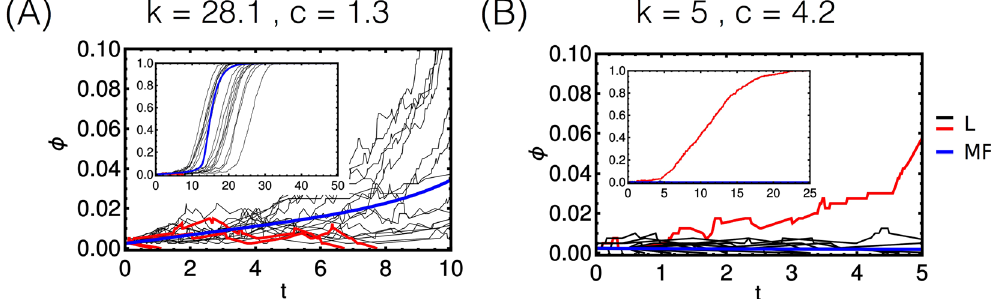
Figure 6. Bi-stability in the spatial model. ( A , B ) Aberrant cell fraction ( φ ) plotted against time for the mean field model (blue line) and for several runs of the spatial model (black lines if the dynamical outcome of the spatial model agrees qualitatively with the spatially homogeneous model, red otherwise), for the different reported values of k and c . Main panels: behaviour for short times. Insets: behaviour for ling